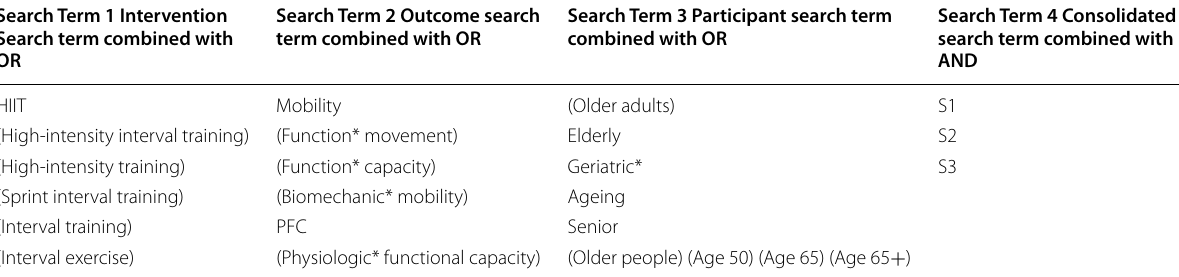
Search Term 2 Outcome search term combined with OR